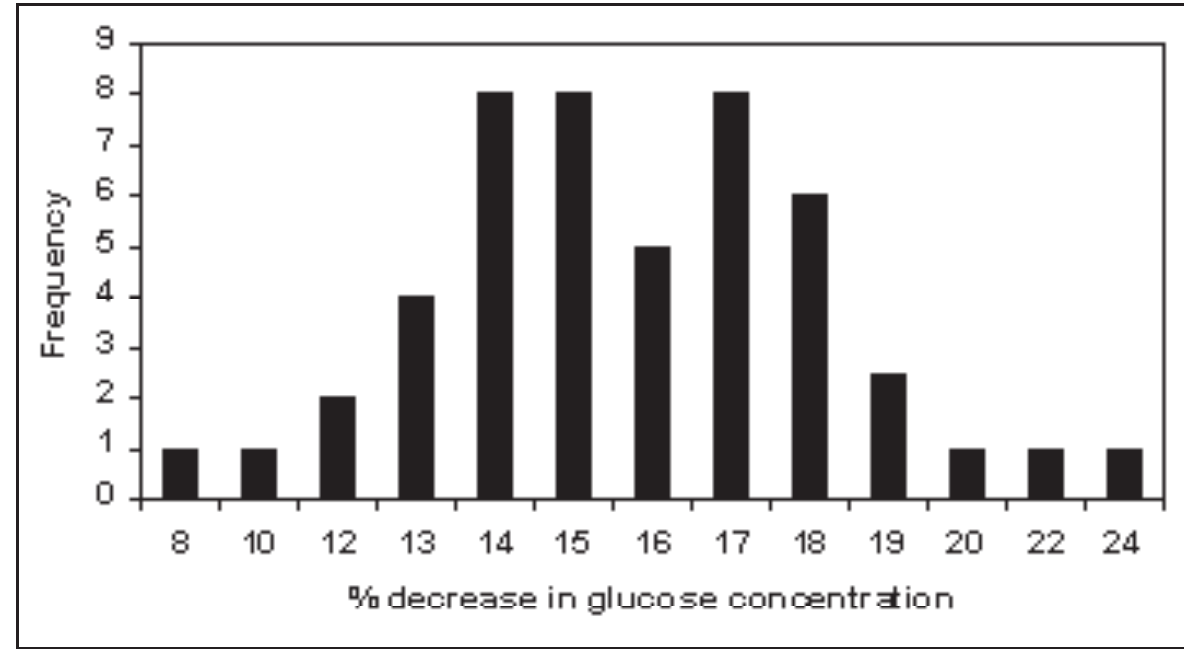
Fig. 1: Frequency distribution of variation in glucose values following processing of replicate samples after three hours of serum-clot